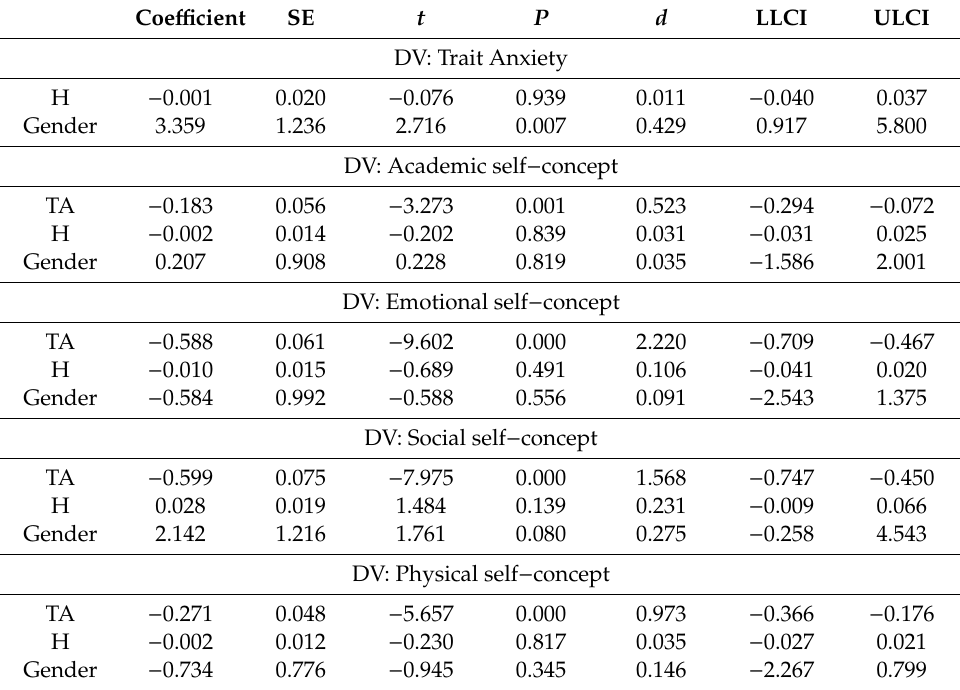
Table 3. Results of the mediational analysis for hyperactivity symptomatology.